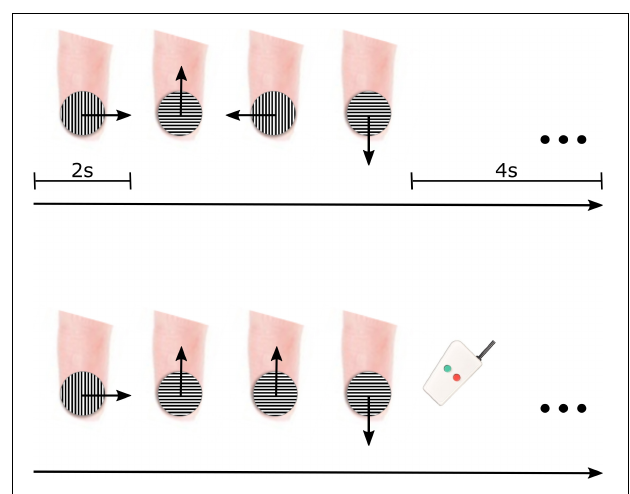
FIGURE 1 | fMRI paradigm for delivering tactile motion. Each 12-s block consisted of all four directions of tactile motion (each direction was simulated for 2 s) followed by a 4-s baseline period (top panel). To ensure participant’s attention, two of the blocks had a direction immediately repeated, and participants were instructed to press a button on the response box when they noticed the repeat (bottom